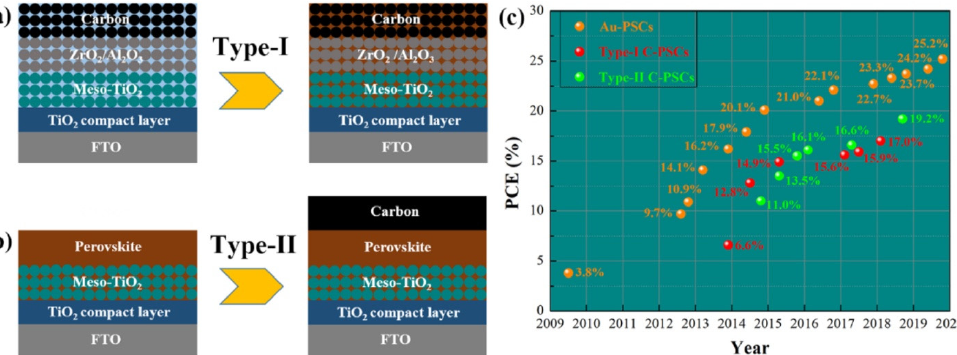
Figure 9 . Schematics of C–PSCs configurations and efficiency evolution. ( a ) Type I C–PSCs based on a typical multi-layer mesoporous structure. ( b ) Type II C–PSCs with a structure similar to Au–PSCs. ( c ) Reported efficiency evolution of different PSCs [55]. (Reproduced from Ref. [55],